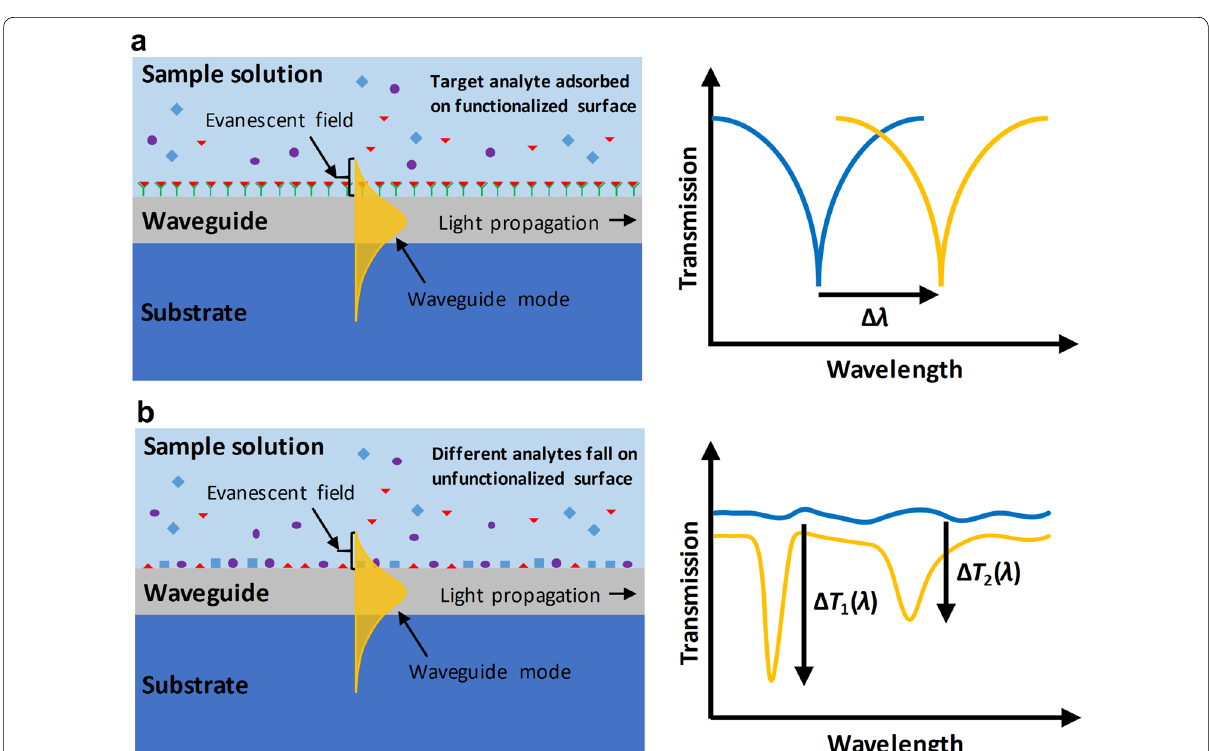
Fig. 2 Schematic illustration of the sensing mechanisms of infrared guided-wave nanophotonic biochemical sensing based on evanescent field detection. a RI-based sensor with its surface functionalized to selectively adsorb analyte. The optical signal change in the sensor, e.g., the resonant wavelength shift in a resonator, is known to be induced by the absorbed analyte. b Absorption-based sensor without surface functionalization. The different analytes adsorbed on the sensor surface are distinguished by their induced characteristic absorption peaks at different wavelengths on the sensor transmission